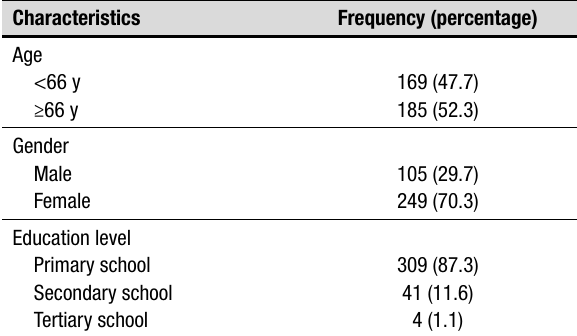
Table 2. Characteristics of the elderly in the included families.